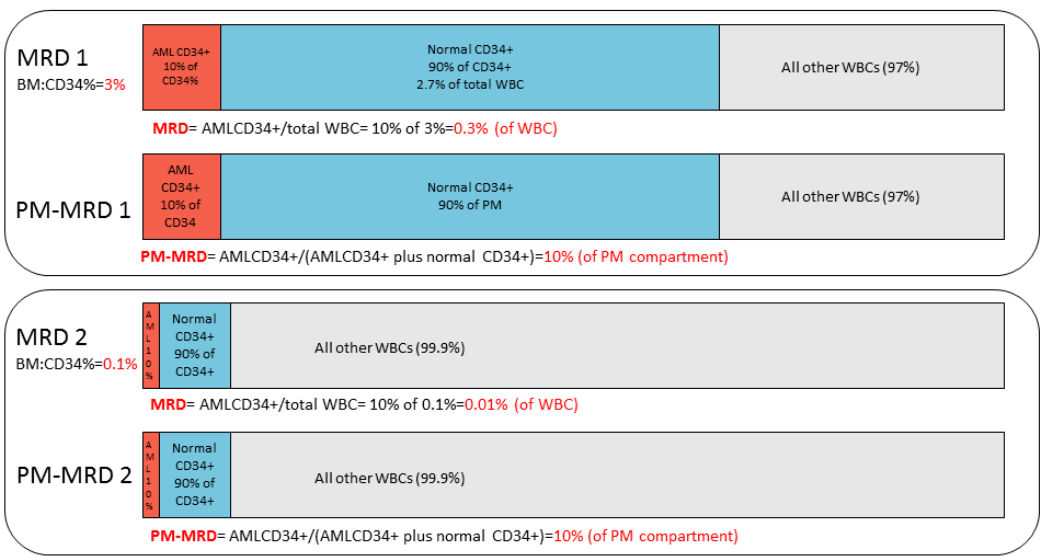
Figure 5. Disturbed relationship between WBC-MRD and PM-MRD. PM-MRD and WBC-MRD positivity in a schematic example of 2 clinical samples differing in terms of CD34 percentage. In example 1, the AML CD34+ cells (in brown) make up 10% of the total CD34+ compartment (brown + blue). Here, PM-MRD is thus 10%. Since the BM CD34+ percentage in this example was chosen to be 3% (of WBC), the AML part of the total WBC population, representing WBC-MRD, was 10% of 3% = 0.3%. In example 2, the PM-MRD was again 10% (in brown), but since the BM CD34+ percentage (brown + blue) in this example was 0.1% (of WBC), the AML part of the total WBC population (WBC-MRD) was 10% of 0.1% = 0.01%. These examples of the most extreme conditions of BM CD34% show that samples 1 and 2 have similar PM-MRD (10% of CD34+ compartment), suggesting that they have similarly poor prognoses (see Figure 2D). On the contrary, sample 1 has a high WBC-MRD (0.3%), suggesting a poor prognosis, but sample 2 has a low WBC-MRD (0.01%), suggesting a good prognosis.